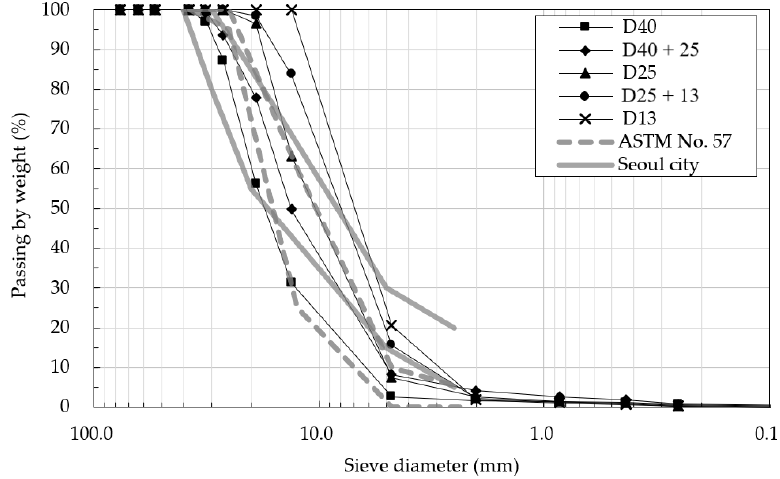
Figure 4. Particle size distribution of test materials and specifications [38].